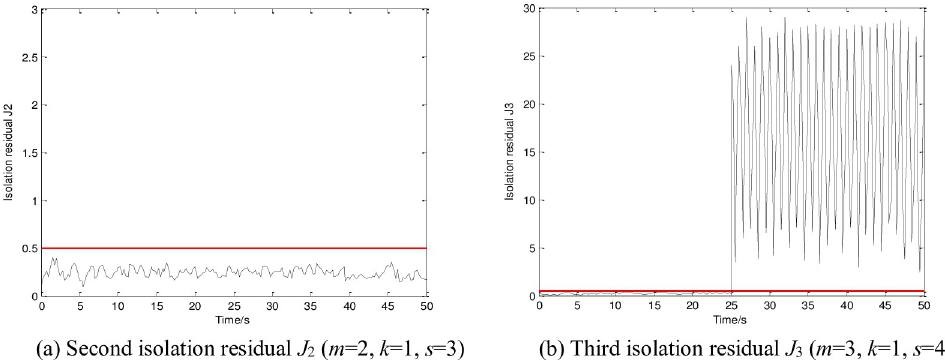
Fig 4. Isolation residuals and threshold. (a) Second isolation residual J 2 ( m = 2, k = 1, s = 3), (b) Third isolation residual J 3 ( m = 3, k = 1, s = 4).